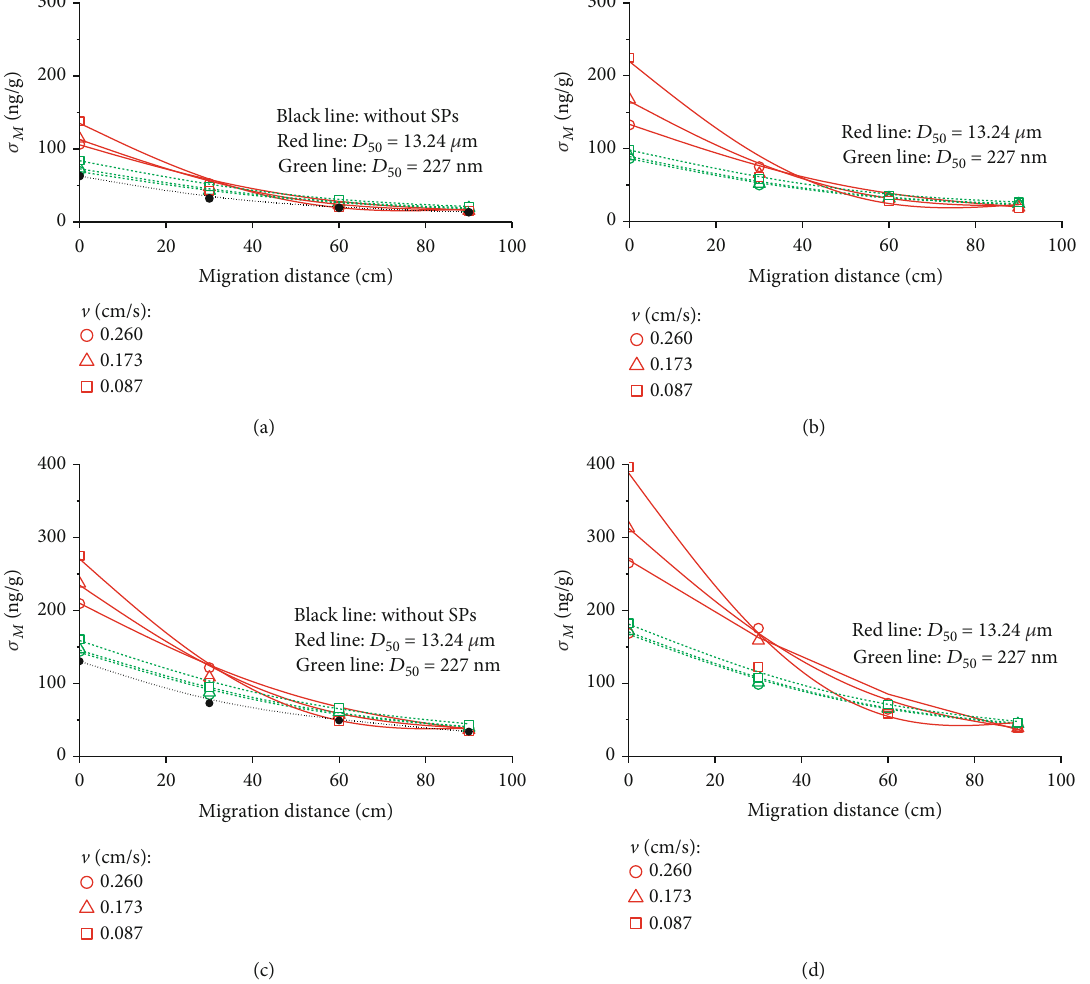
C : 5mg/ml ; (b) C M = 100ng/ml , S = 0 M = 100ng/ml